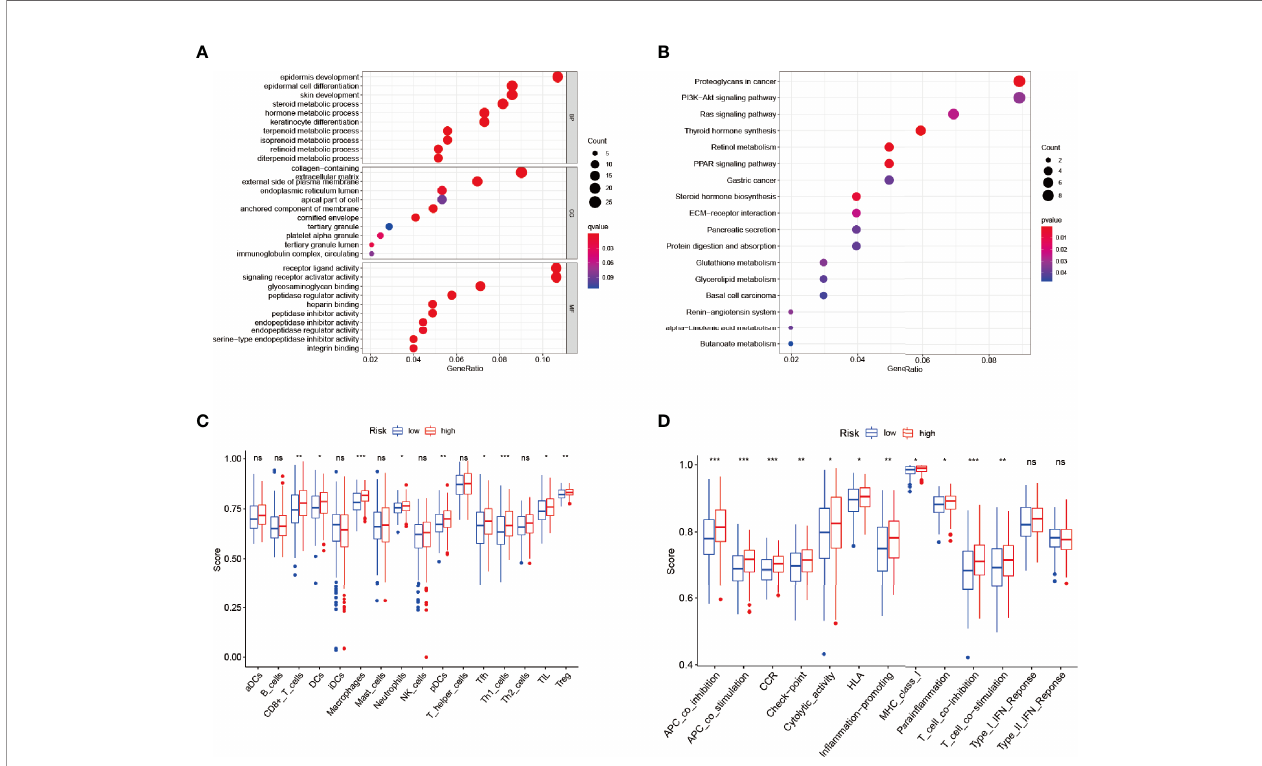
FIGURE 6 | Enrichment analysis and ssGSEA scores. (A, B) GO and KEGG analyses. (C, D) Comparison of the ssGSEA scores between the different risk groups: Scores of the 16 immune cells and Scores of the 13 immune-related functions. *P < 0.05, **P < 0.01, ***P < 0.001, ns, no signi fi